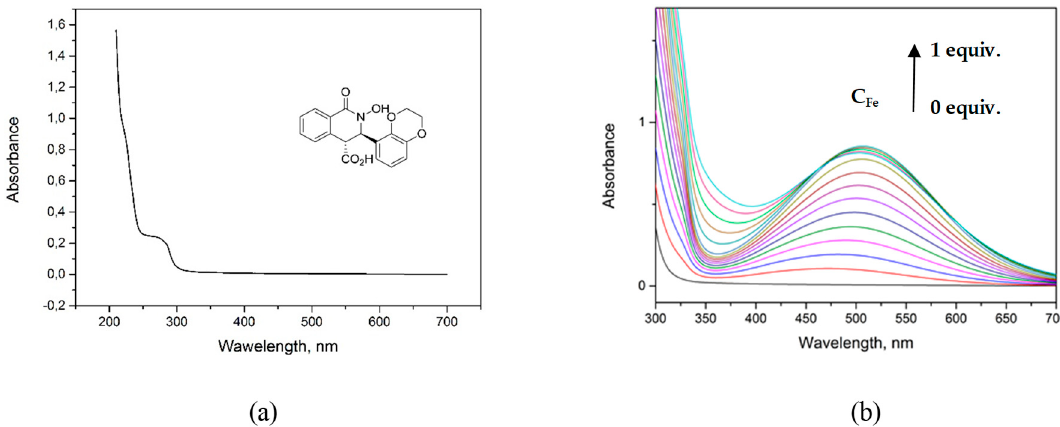
Figure 2. ( a ) UV-Vis absorbance spectrum of compound 7d in methanol (C = 5 × 10 − 5 M); ( b ) UV-Vis absorbance spectrum of compound 7d (C L = 5 × 10 − 4 M, aq. MeOH 85%) in the presence of increasing concentration of Fe 3+ (C Fe = 0.25 ‒ 5 × 10 − 4 M).